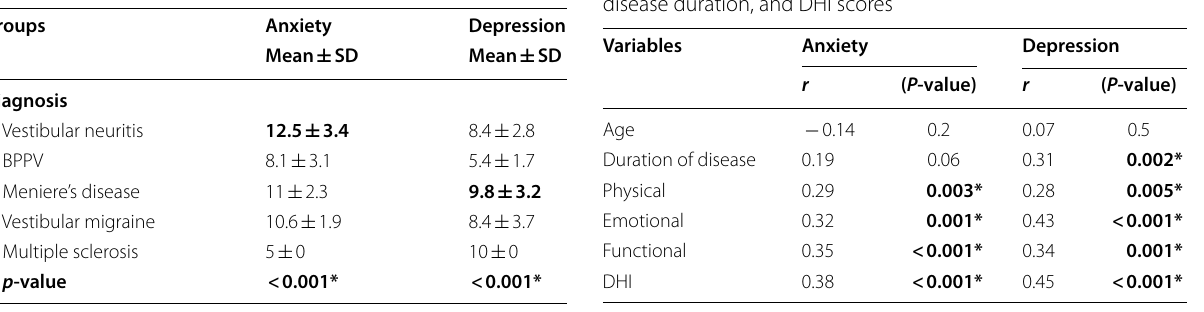
* P -value< 0.05 was considered as statistical significant Table 5 Comparisons of Age & DHI subscales with HADS scores Groups